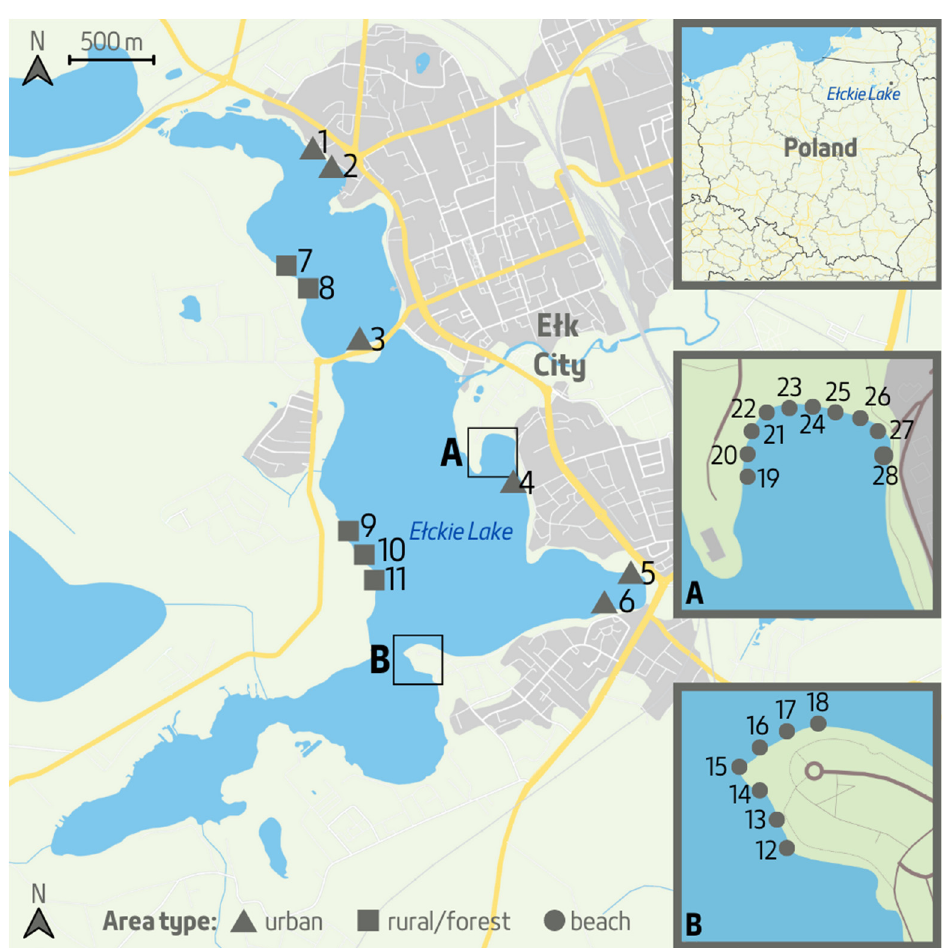
Figure 1. The location of 28 research points on E ł ckie Lake, Poland.